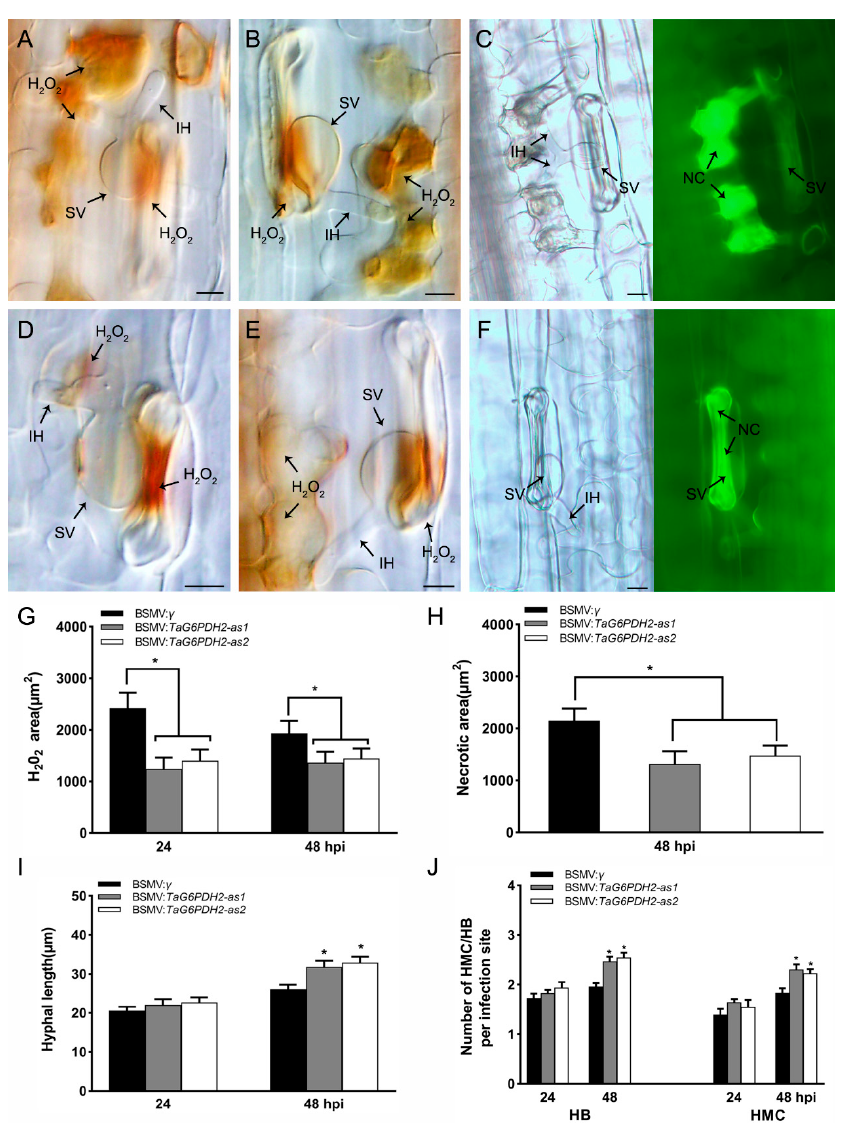
Figure 5. Histological observation of host response on the silenced wheat leaves infected with Pst CYR23. A-C. H 2 O 2 accumulation, detected by DAB staining, at 24 hpi ( A ) or 48 hpi ( B ) and the necrotic cells at 48 hpi ( C ) in BSMV: γ -treated plants as a negative control. D-F. H 2 O 2 accumulation at 24 hpi ( D ) or 48 hpi ( E ) and the necrotic cells at 48 hpi ( F ) in BSMV: TaG6PDH2 -treated plants. Scale bars, 20 μ m. SV, substomatal vesicle. IH, infection hypha. NC = necrotic cell. ( G ) H 2 O 2 accumulation per infection site in the silenced wheat leaves, recorded at 24 and 48 hpi. ( H ) Necrotic area per infection site in the silenced wheat leaves, recorded at 48 hpi. ( I ) Hyphal length per infection site in the silenced wheat leaves, recorded at 24 and 48 hpi. ( J ) The numbers of haustorial mother cells (HMC) and branches of infection hyphae (HB) per infection site in the silenced wheat leaves, recorded at 24 and 48 hpi. At least 30 infection sites from randomly selected leaf segments were counted for each replicate. Each data point represents the mean ± SD from three independent biological repetitions. Asterisks represent significant differences ( p < 0.05) compared with controls, according to Student’s t -test.